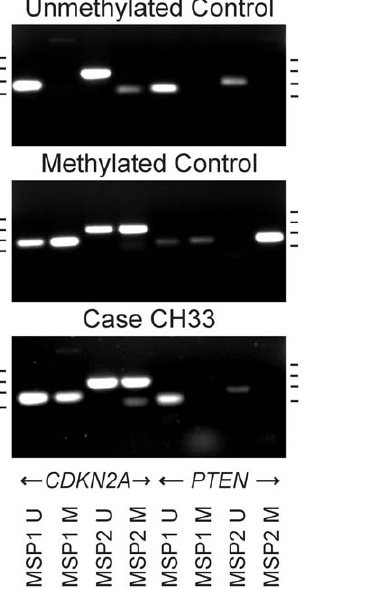
Figure 5. CDKN2A and PTEN methylation specific PCR. Bisulfite- treated chordoma DNA samples were tested with methylation specific PCR to evaluate for hypermethylation of the CDKN2A and PTEN promoter regions. Two sets of unmethylated (U) and methylated (M) PCR primers were used for each target gene (bottom labels, MSP1 and MSP2). Unmethylated and methylated controls are shown along with results for case CH33. Results for other tested cases are summarized in Tables 3 and 4 under the CDKN2A and PTEN MSP1 and MSP2 columns. Tick marks on the left and right of each panel indicate 100, 200, 300, and 400 base pair sizes (bottom to top).